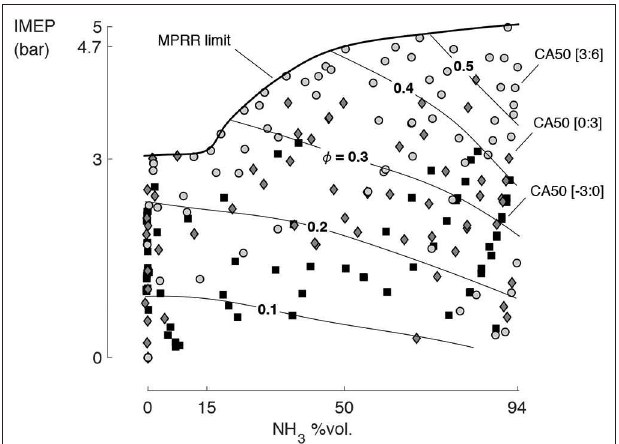
FIGURE 6 | The achievable IMEP is tapering off as the MPRR increases due to an increased heat and friction losses (all experimental points). Ammonia allows higher IMEP due to a reduced MPRR for a given fuel loading and the major share of IMEP rise occurs between 15 and 50%vol. of ammonia.